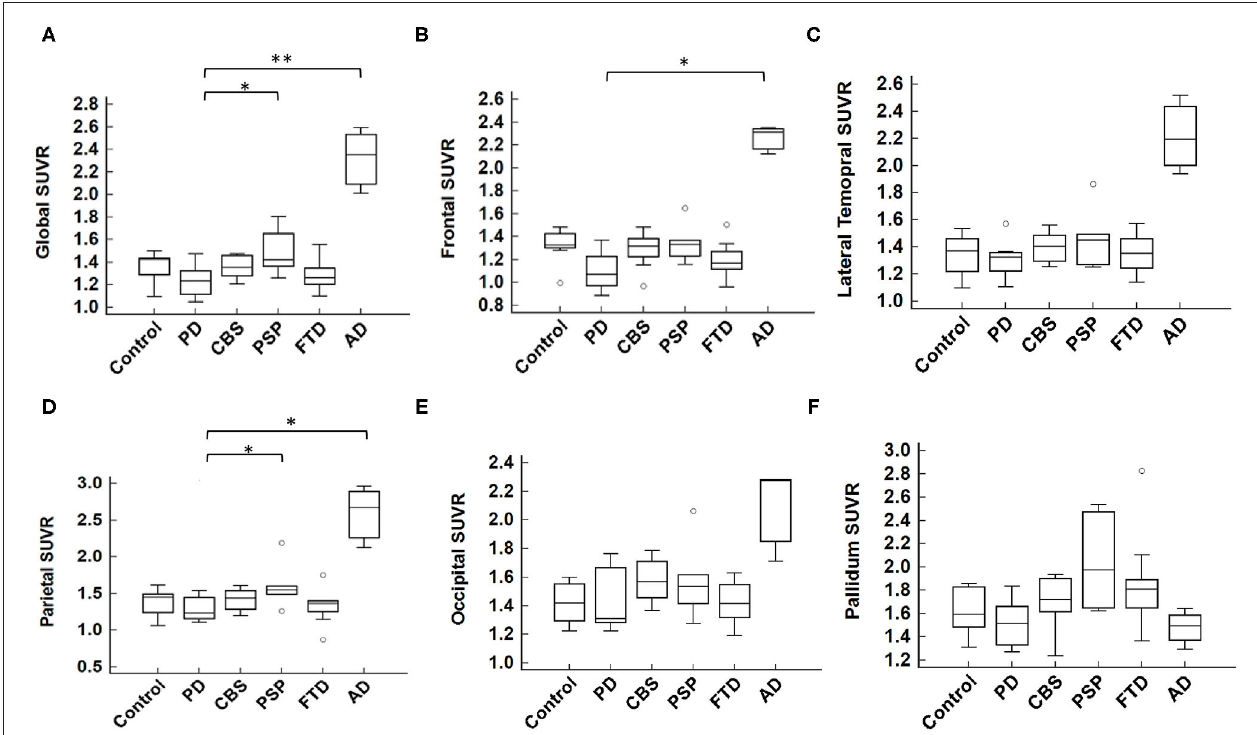
FIGURE 2 | Mean 18 F-T807 SUVR in global or regional cerebral cortex. (A) The global SUVR was significantly different between groups ( p = 0.007, Kruskal-Wallis test). Comparing to the synucleinopathy disorder of PD, the global SUVR value of AD was statistically significantly higher than that of PD; while the PSP group had a modestly increased SUVR compared to the PD group (AD vs. PD, p = 0.002; PSP vs. PD, p = 0.044, by post hoc Conover test, with Bonferroni correction for multiple comparisons). In individual brain regions, including (B) frontal, (C) lateral temporal, (D) parietal, (E) occipital, and (F) pallidum, the SUVR was significantly higher in the frontal and parietal cortices in AD group and modestly higher in PSP group in the parietal cortex as compared to the PD group. * p < 0.05, ** p < 0.01.